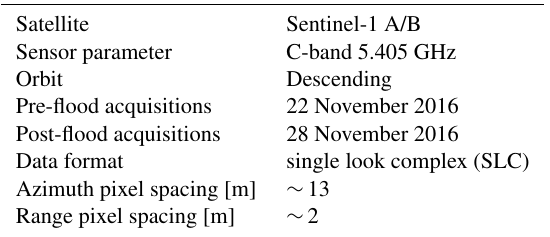
Table 3. Characteristics of the Sentinel-1 dataset used in this